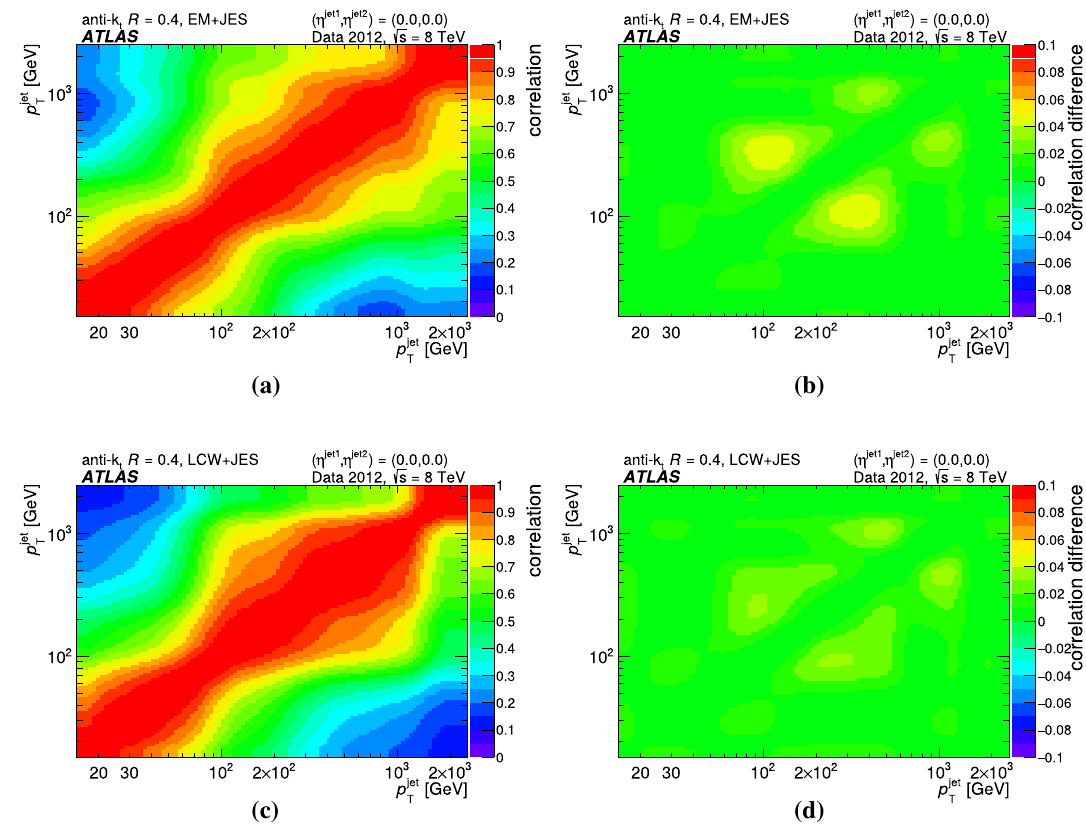
Fig. 45 The a , c JES correlation matrix and b , d difference between the full correlation matrix and that derived from a reduced number (6) of absolute in situ uncertainty components for anti- k t R = 0 . 4 jets calibrated with the a , b EM+JES and c , d LCW+JES